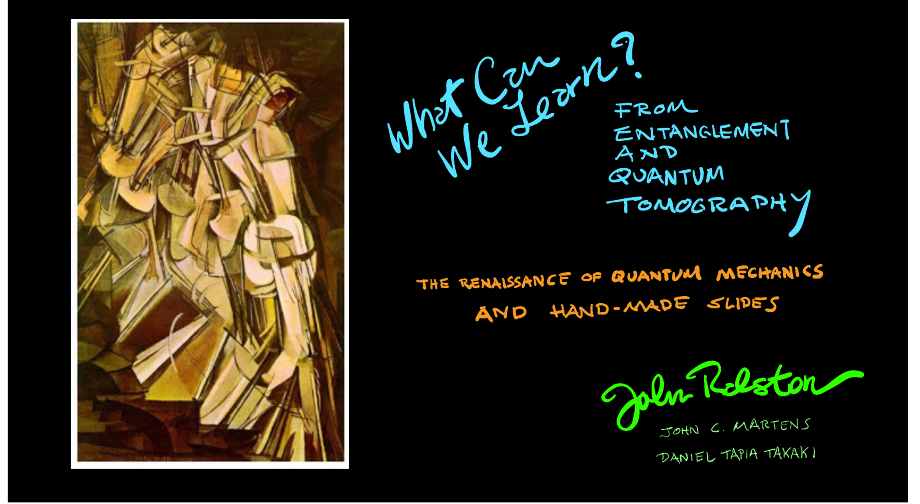
Figure 1. The first slide from an old technology that is new